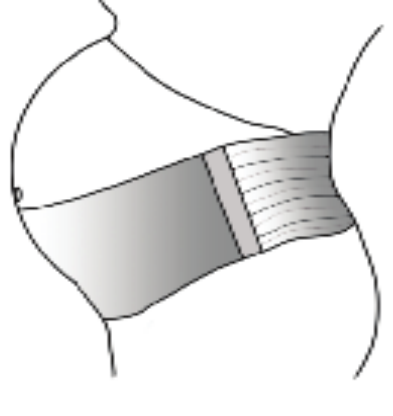
Figure-VIII: A belly